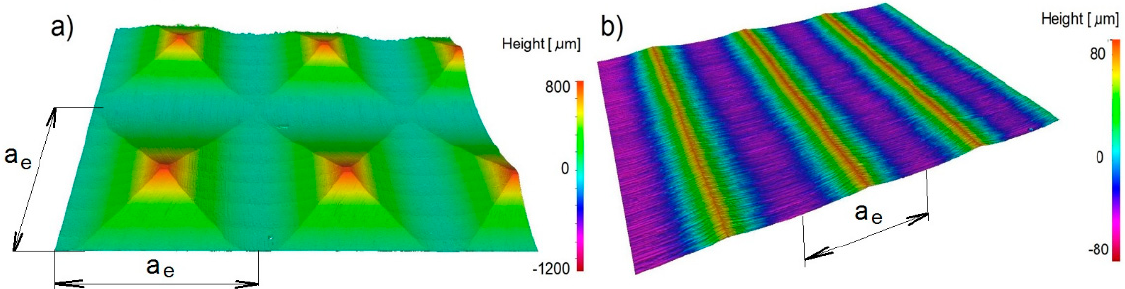
Figure 11. Surface topography in ball end milling process: ( a ) milling with transverse and longitudinal steps with radial stepovers a e × a e , ( b ) milling solely in longitudinal steps a e .